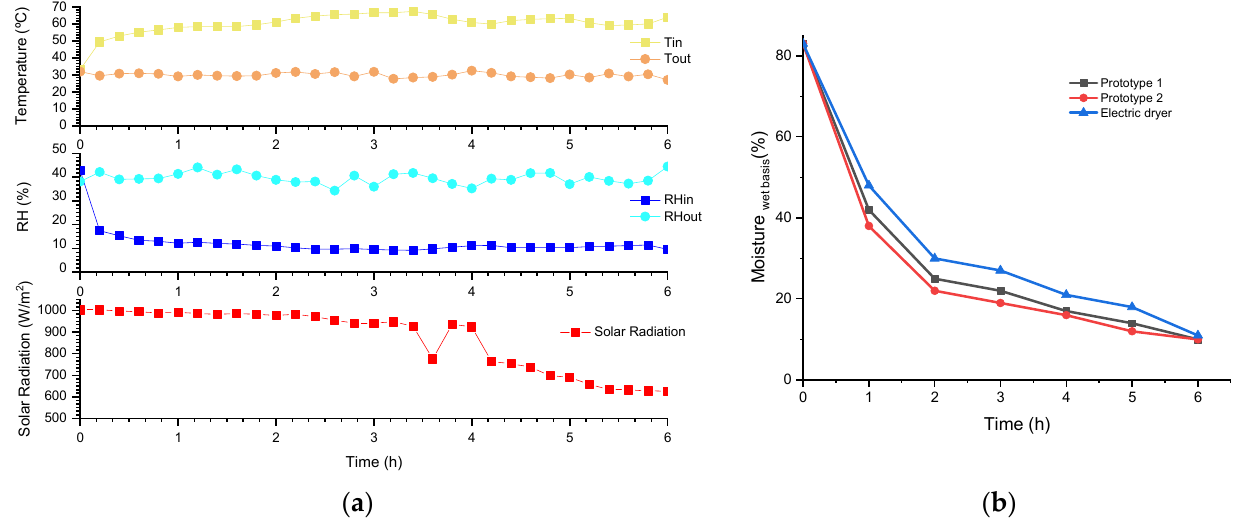
Figure 8. ( a ) Time evolution of the measured solar radiation, temperature, and RH (inlet and outlet) of a representative day of solar drying; ( b ) Comparison of moisture loss, in a wet basis, of apple slices, in an electric dryer and in our prototypes on the same day of ( a ).